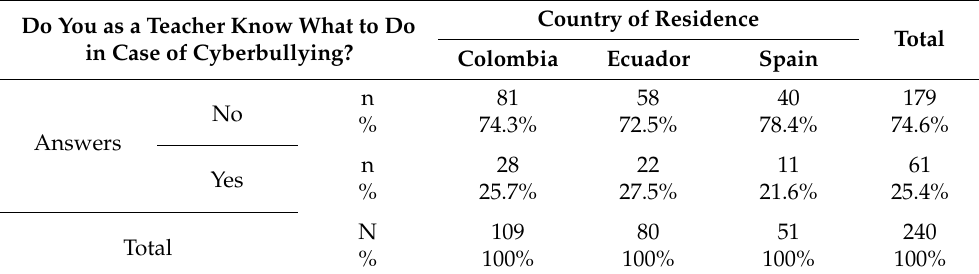
Table 5. Cross-categorization of the variable “Do you know how to deal with cyberbullying?” and the variable “Country of residence”.